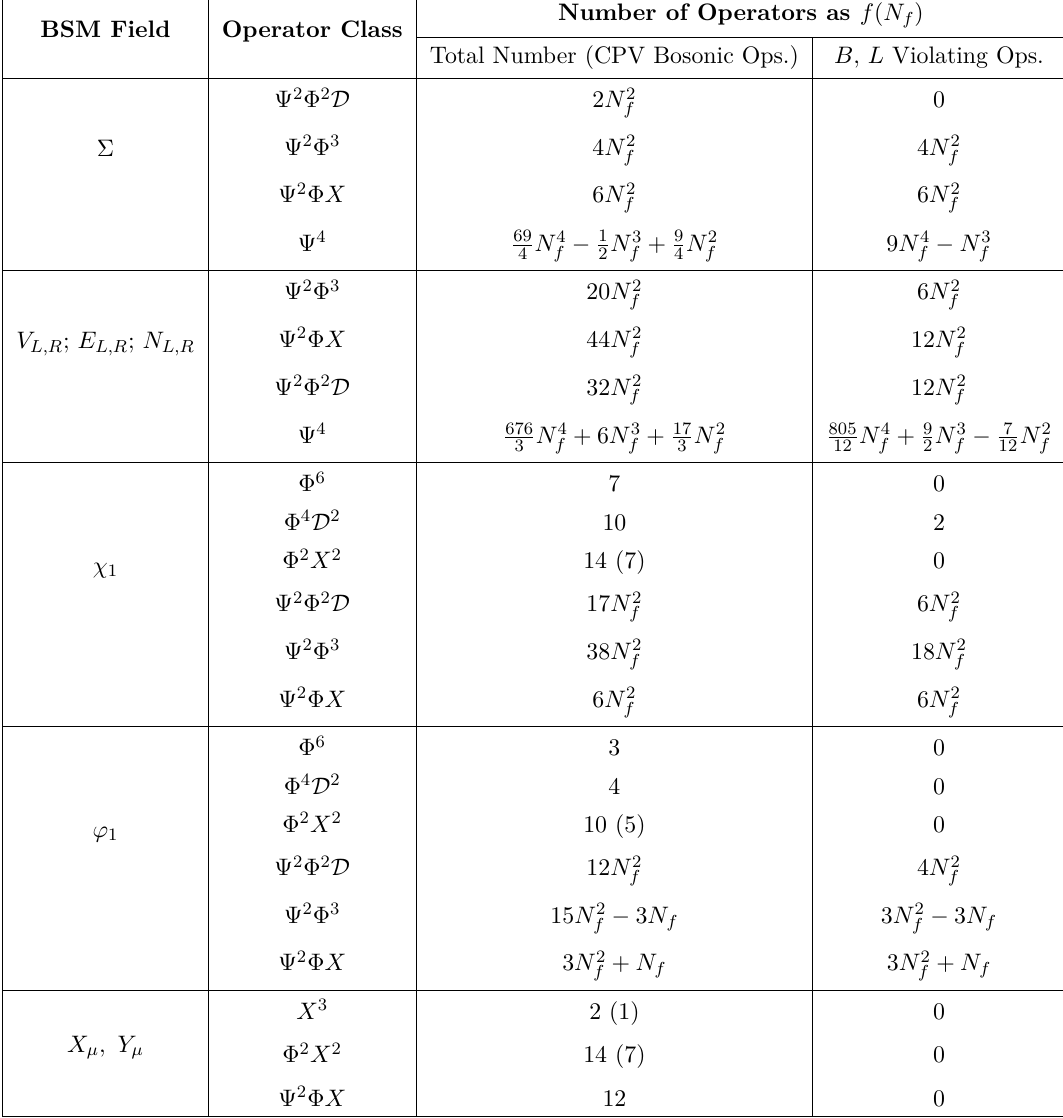
Table 27 . Table 26 continued. The numbers in parentheses denote the counting for CP violating purely bosonic